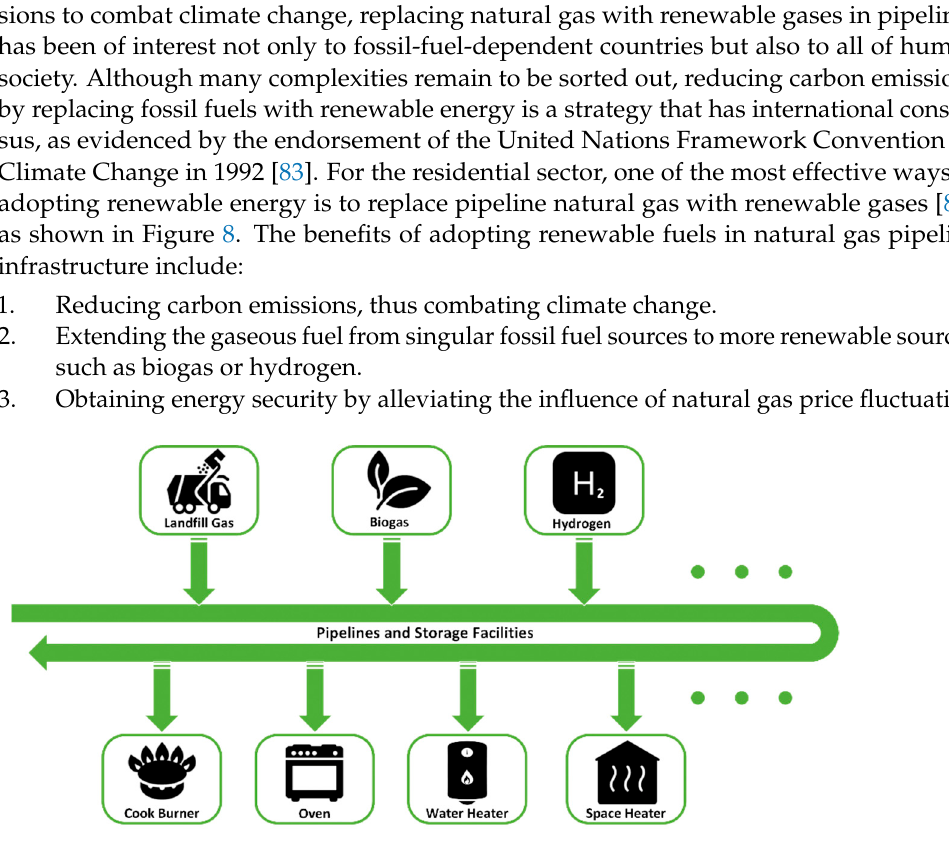
Figure 8. Blending renewable gases into existing natural gas infrastructure.